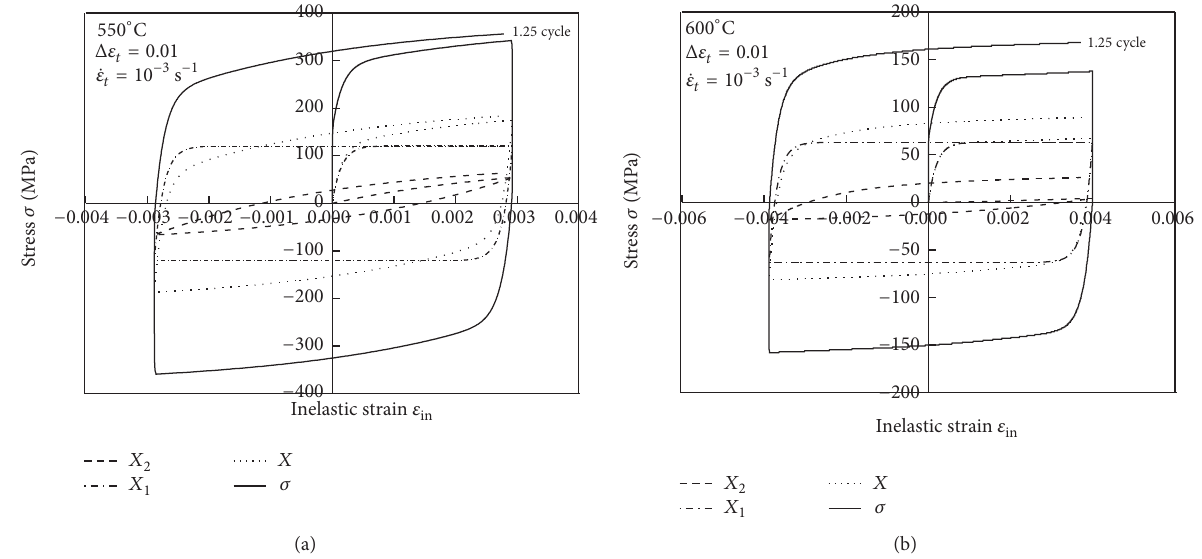
Figure 8: Back stress behavior simulated by the proposed constitutive model for (a) a modified 9Cr-1Mo steel and (b) a 316 stainless steel.